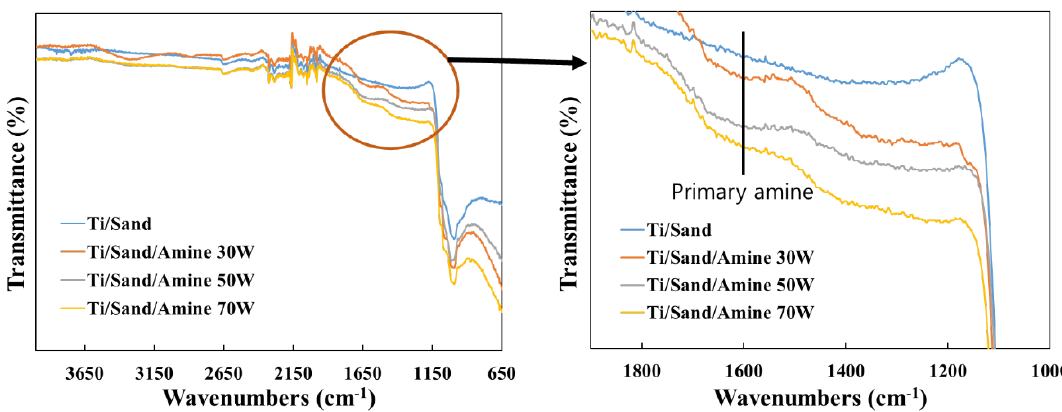
Figure 4. Fourier transform infrared (FT-IR) spectra of the SLA-treated Ti surface and amine plasma-polymerized Ti surfaces under three different plasma powers.